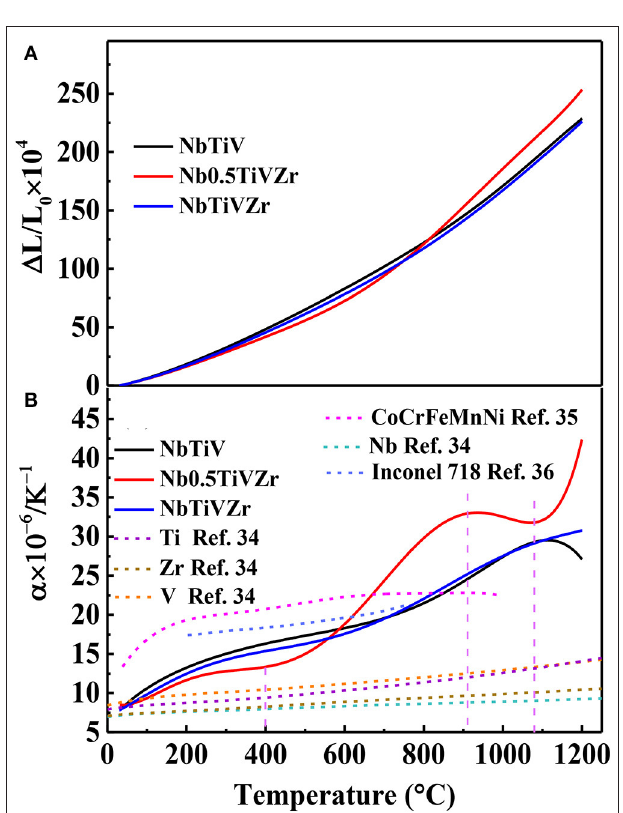
FIGURE 6 | Thermal expansion data. (A) Relative change in specimen length 1 L / L 0 of the NbTiV, Nb0.5TiVZr, and NbTiVZr alloys with temperature. (B) Coefficient of thermal expansion a as a function of temperature for NbTiV, Nb0.5TiVZr, and NbTiVZr alloys, Ti, Zr, V, and Nb pure metals, CoCrFeMnNi HEA, and Inconel 718 Ni-based